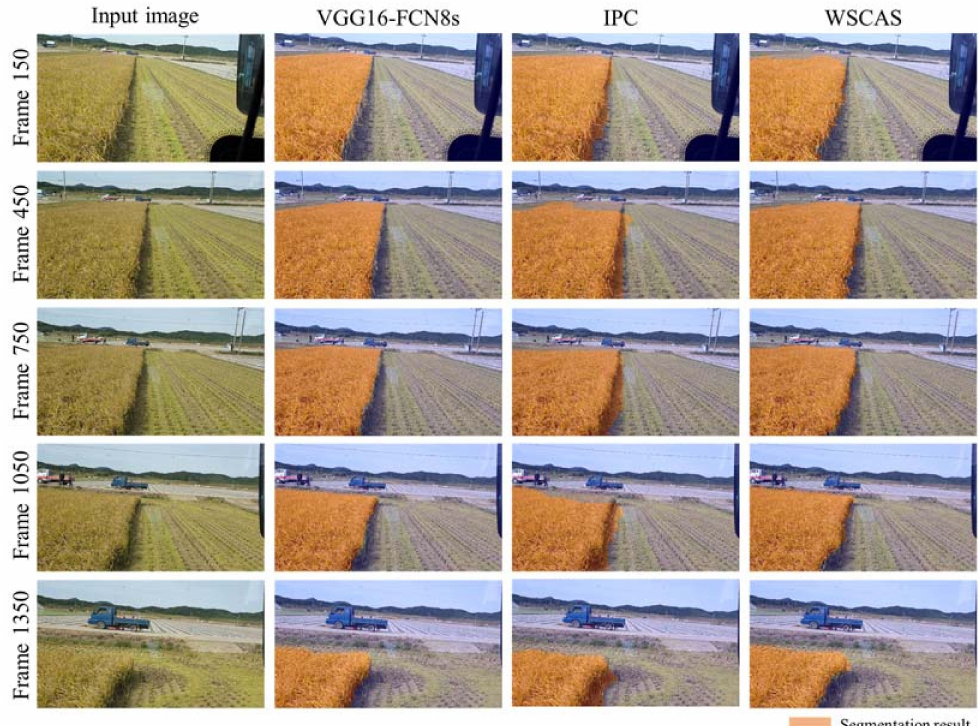
Figure 4. Representative segmentation results for several frames that have 300 regular intervals from the top to the bottom row. Each row consists of 4 images: the input image and the segmentation results using VGG16-FCN8s, IPC, and WSCAS from left to right.